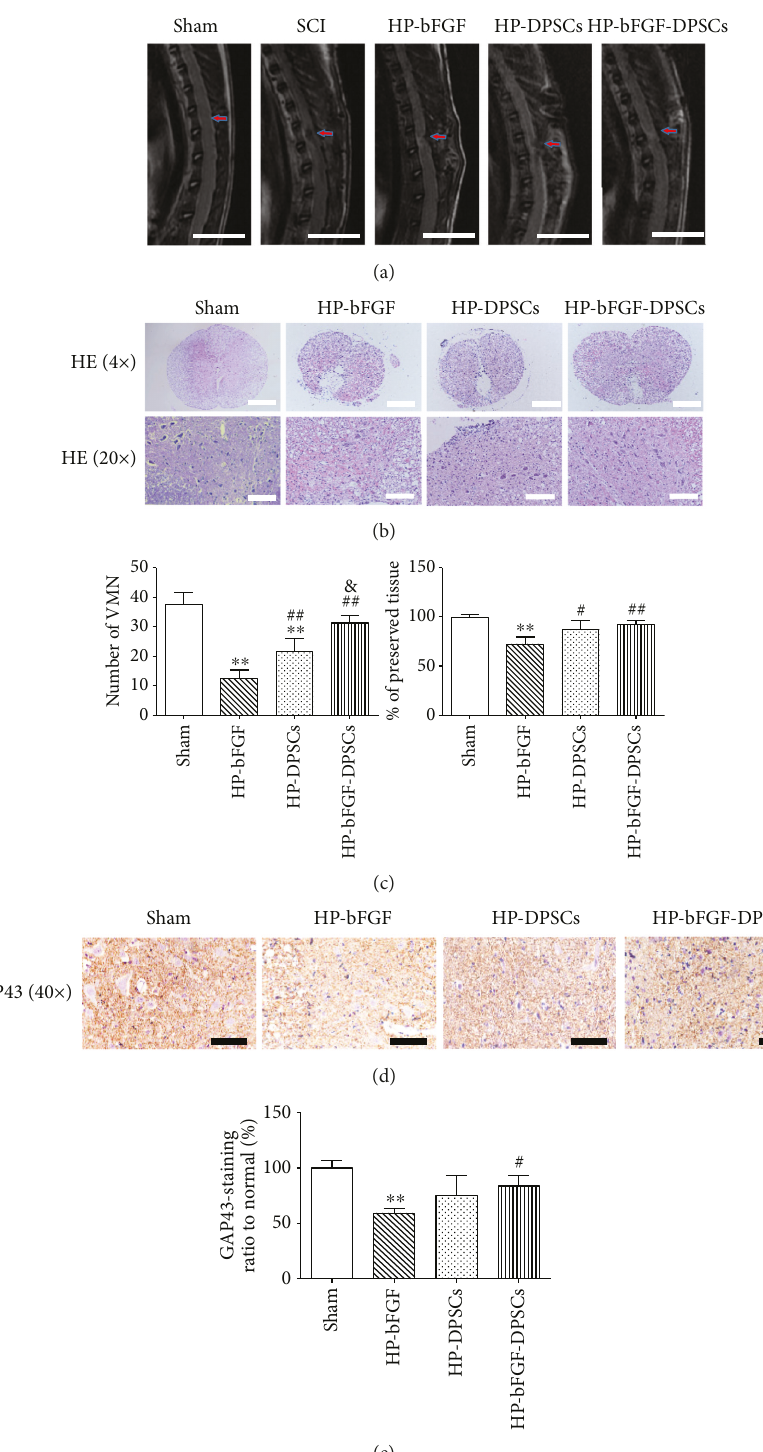
Figure 7: The analyses of MRI, histology evaluation, and immunohistochemistry. (a) MRI images of HP-bFGF, HP-DPSC, and HP-bFGF- DPSC groups at day 28, and SCI modeling stage at 6 hours. Arrows indicated the segmental SCI. Scale bar: 1cm. (b) Representative images of HE staining at day 28. Scale bar: 500 μ m (4 × ) and 100 μ m (20 × ). (c) Quanti fi cation of the number of ventral motor neurons (VMNs) and the percent of preserved tissue in the gray matter of spinal cord. (d) Representative images of GAP43 from immunohistochemisty. Scale bar: 50 μ m. (e) Quanti fi cation of the GAP43 positive staining ratio to normal in spinal cord. The quanti fi cation results obtained by Image J. Data were presented as mean ± standard error from 3 rats in each group. ∗∗ P < 0 01 versus sham group; # P < 0 05 , ## P < 0 01 versus HP-bFGF group; & P < 0 05 versus HP-DPSC